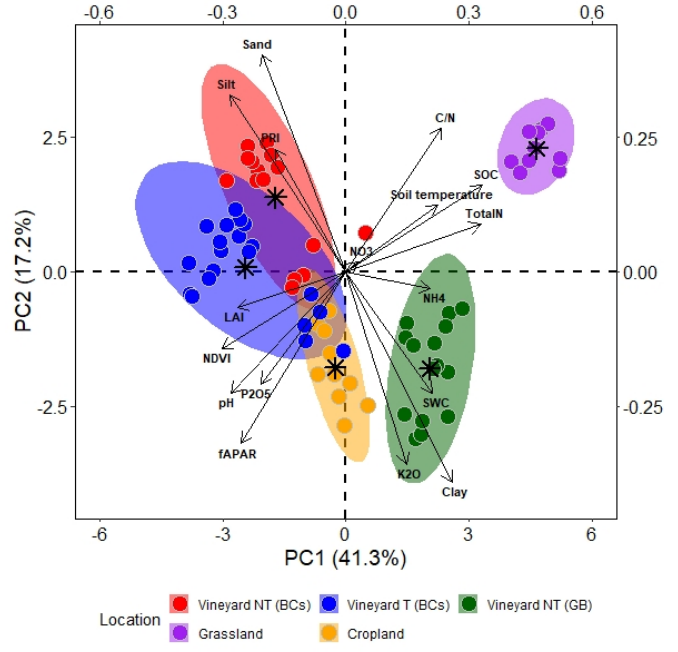
Figure 6. Principal component analysis (PCA) ordination biplot for the five selected slopes with environmental variables (selected soil parameters and plant traits) represented as vectors, and the pairwise representation of the study sites. Asterisks represent the study site averages.